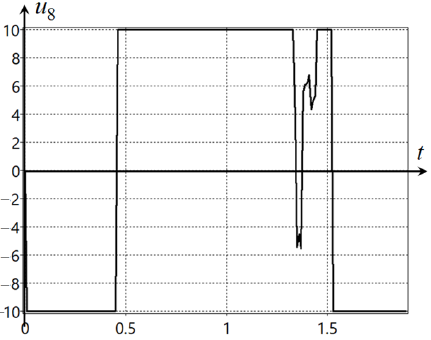
Figure A14. Plot of optimal values of control component u 8